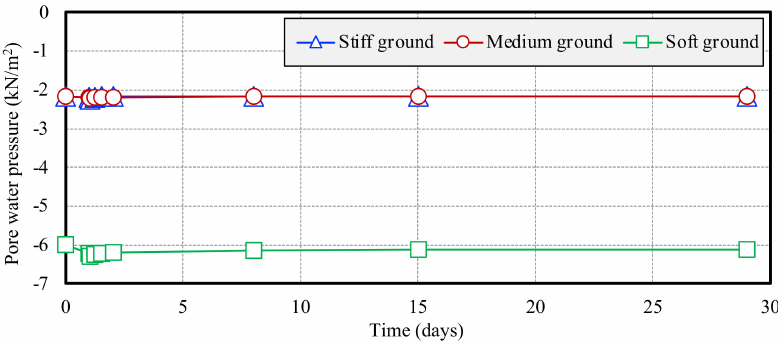
Figure 7. Rates of change in pore water pressure for double boreholes left vacant.